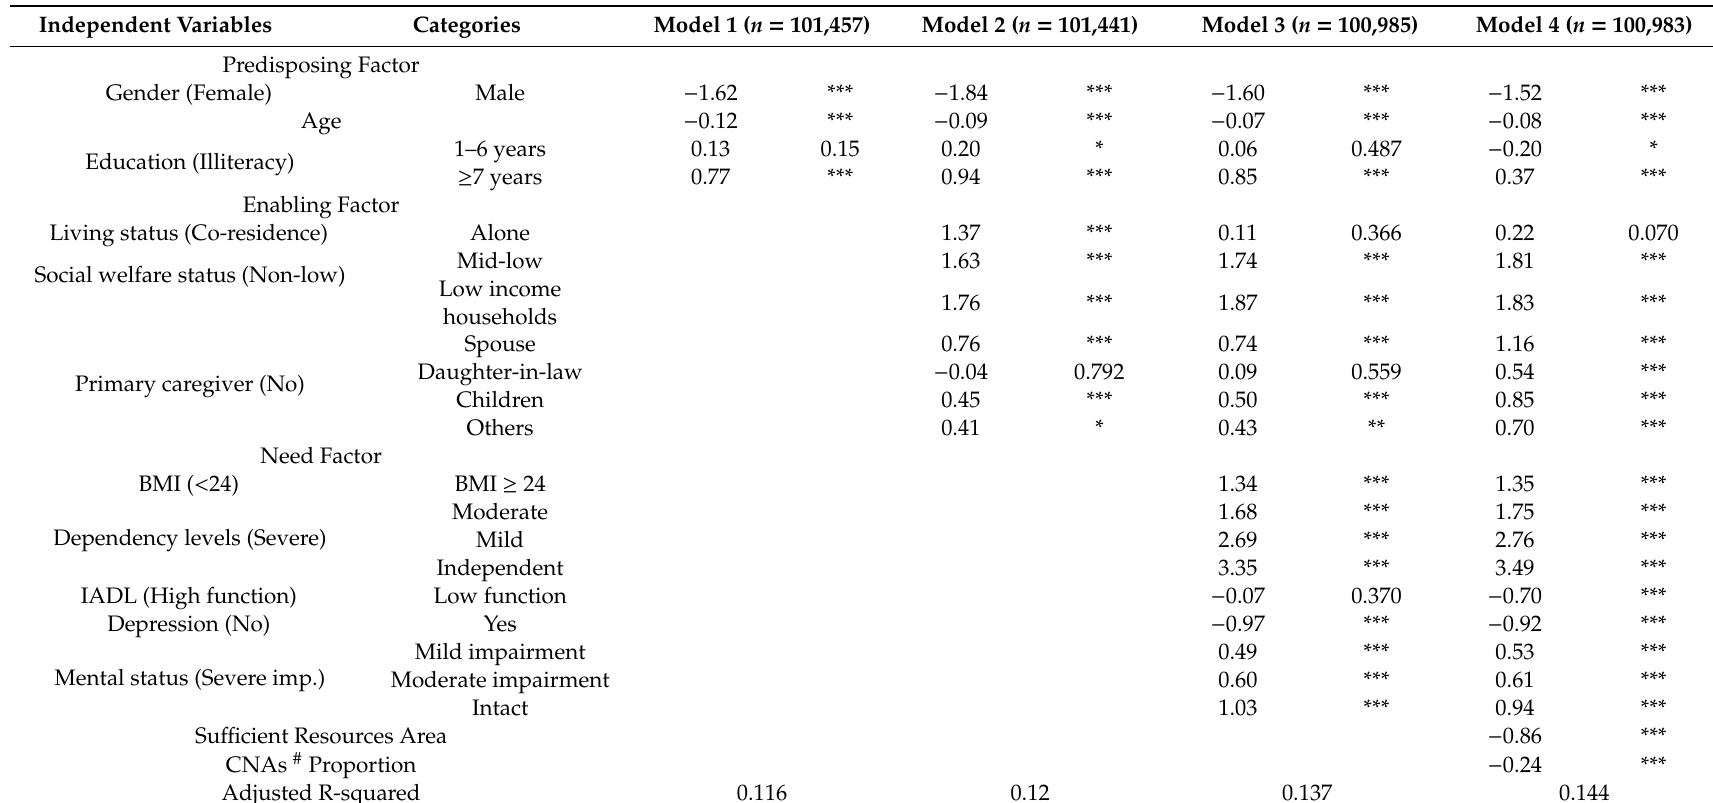
Table 2. The influencing factors of the HCBS utilization period as determined by multiple regression